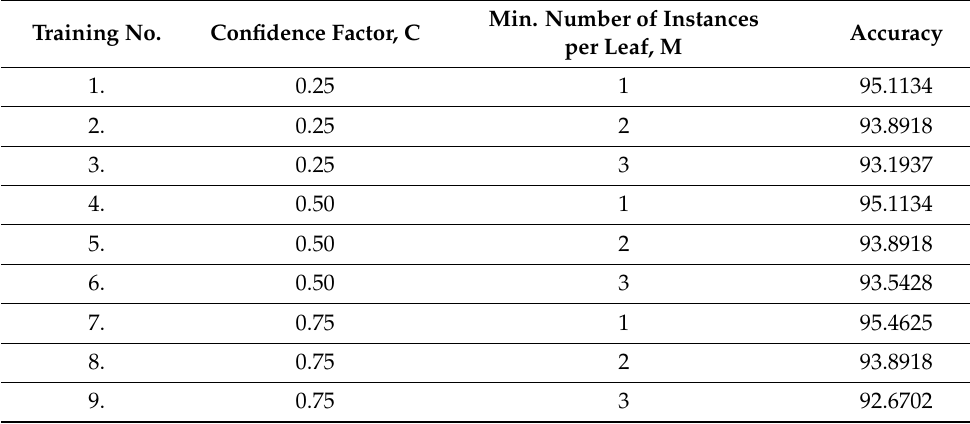
Table 10. Prediction accuracy of j48 decision tree hyperparameter optimization. Training